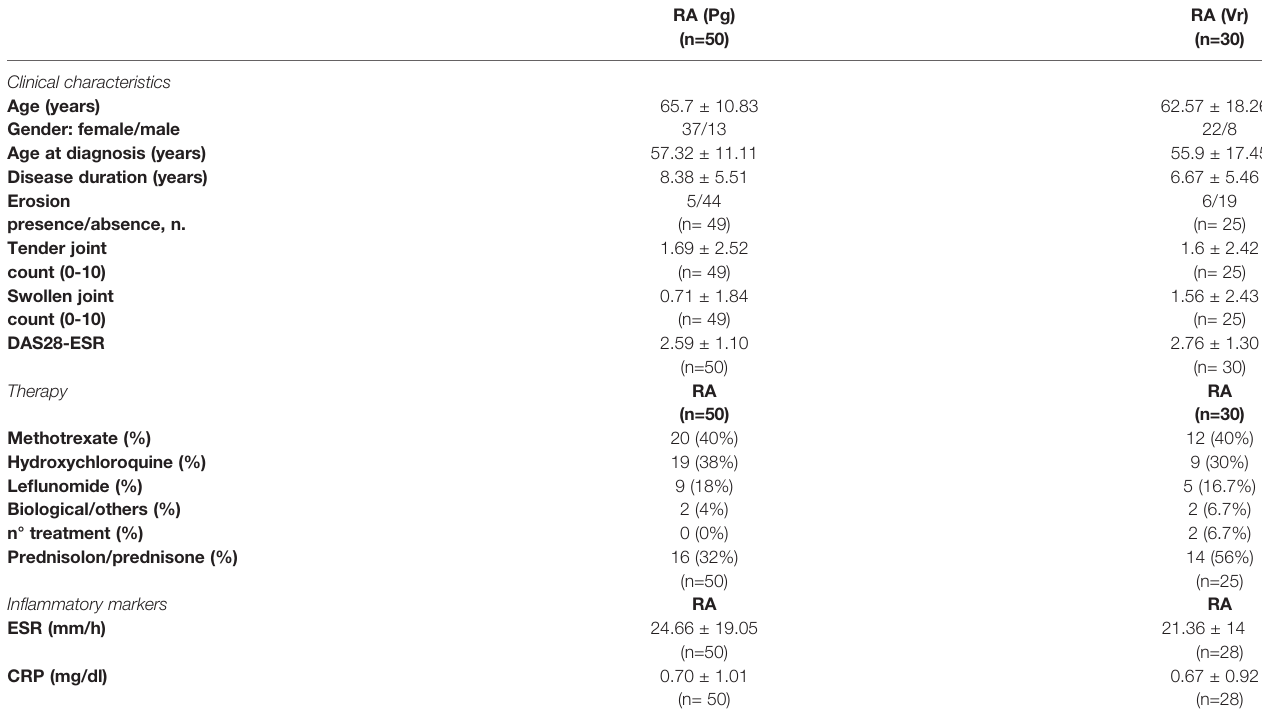
TABLE 1 | Clinical and laboratory features and treatment of seronegative rheumatoid arthritis (RA) patients from the Perugia (Pg) and Verona (Vr)